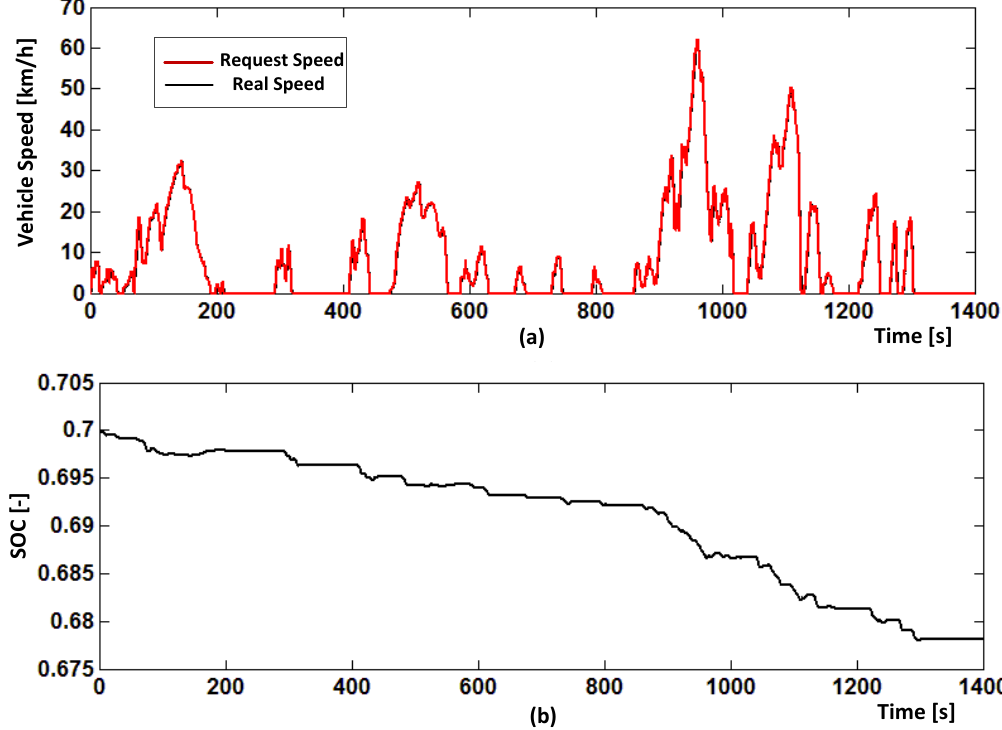
Figure 14. Simulation results for a single driving cycle 1 (1). ( a ) the simulated vehicle speed and the actual vehicle speed; ( b ) the battery SOC .